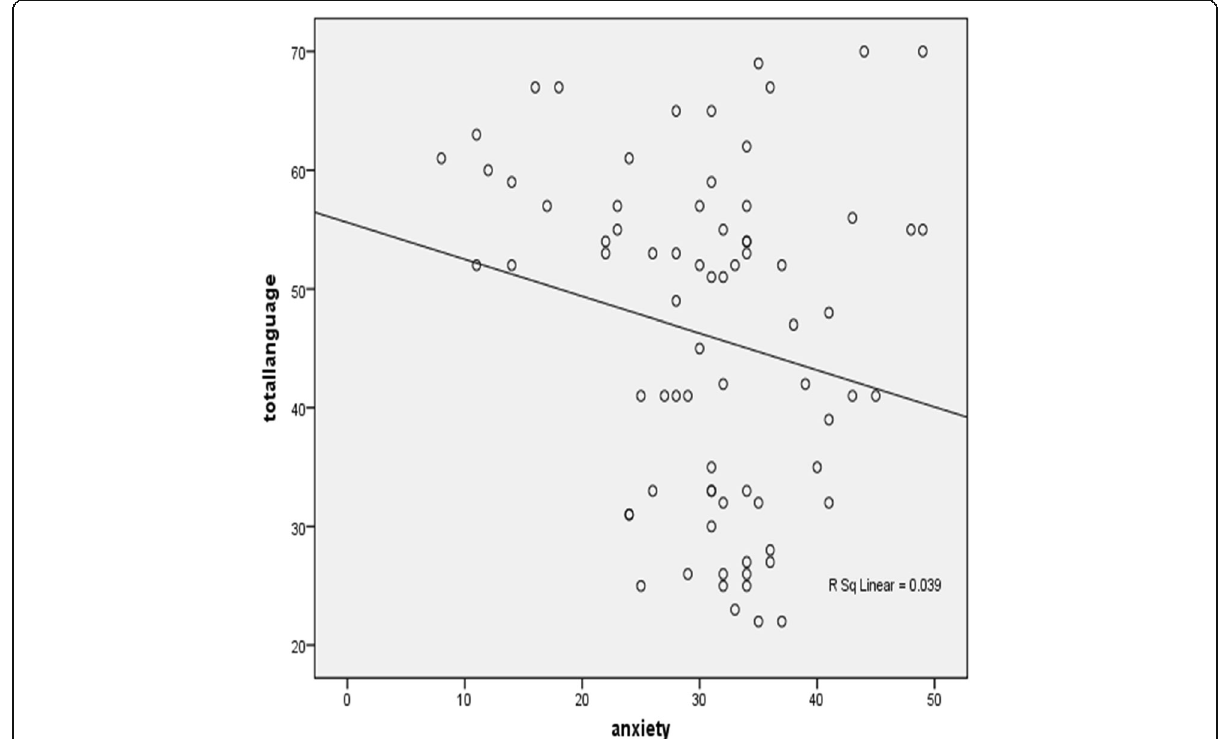
Fig. 5 Shows significant negative correlation between total language ages and Child Anxiety Related Emotional Disorders (SCARED) ( R = - .197)